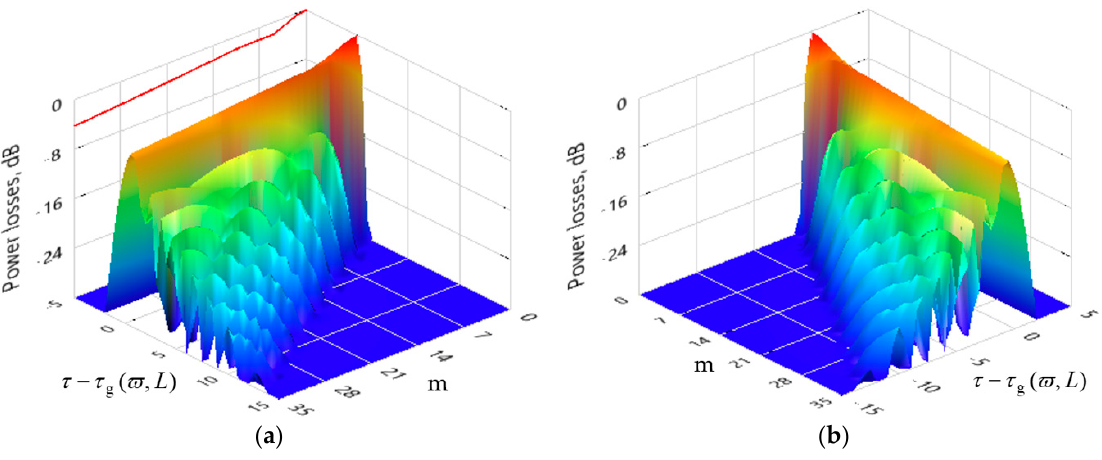
Figure 4. The short pulse collapse in fiber: ( a ) TOD > 0; ( b ) TOD <